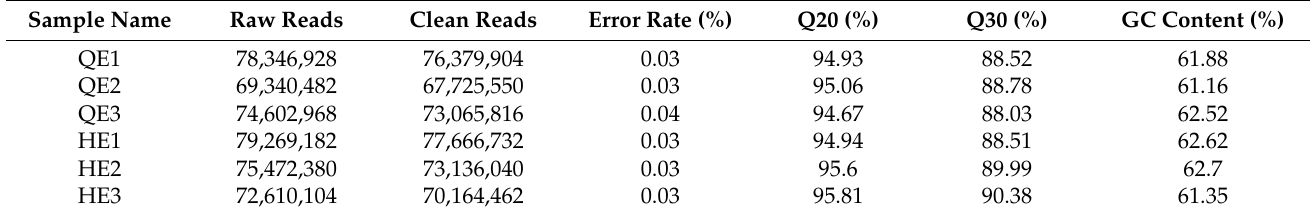
Table 1. Quality summary of sequencing